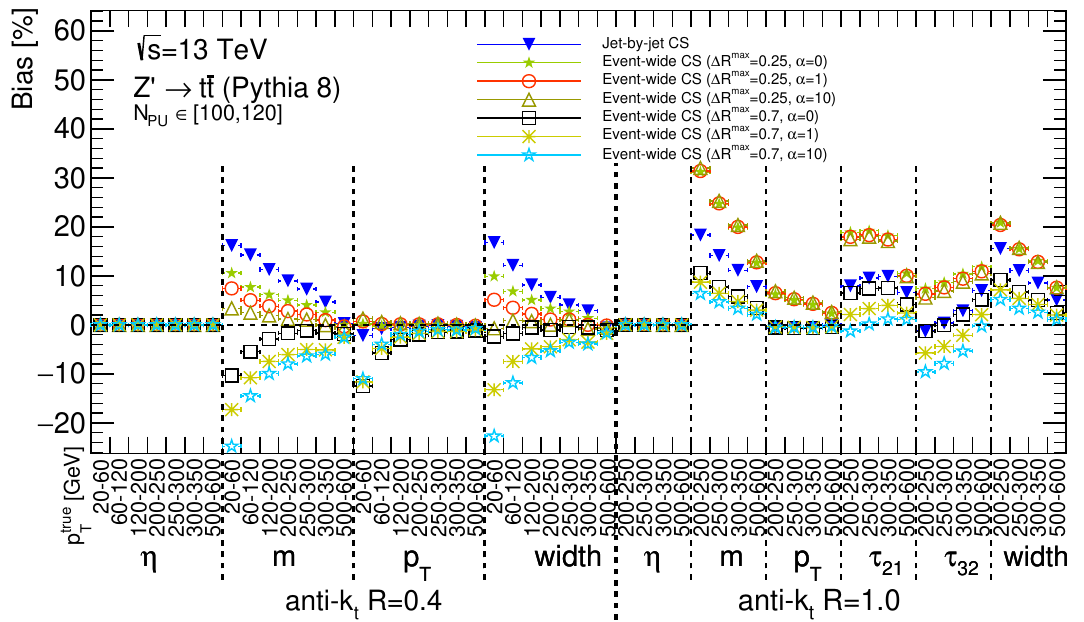
Figure 14. Dependence of bias on the (cid:11) parameter for the Event-wide